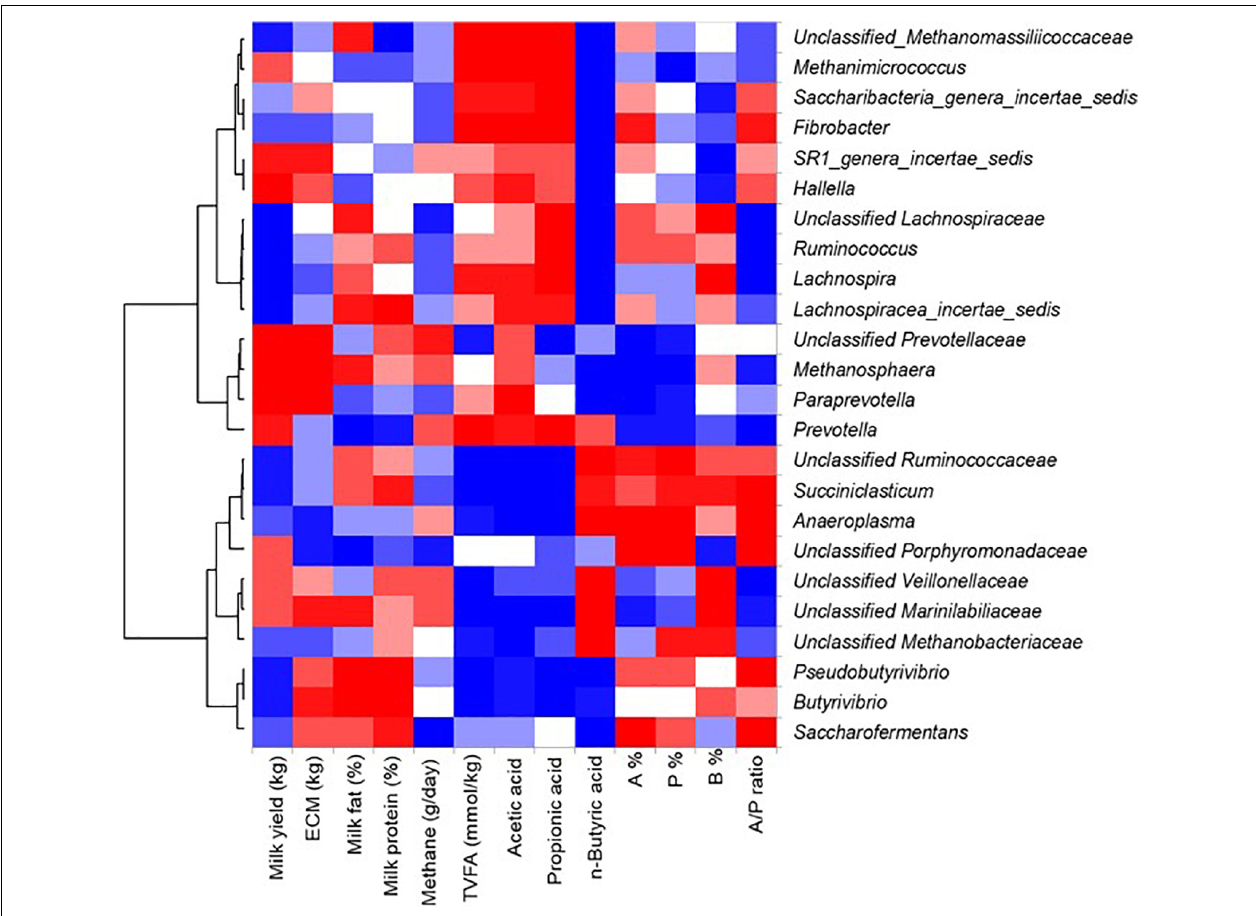
FIGURE 7 | Correlation between SCFAs, milk traits and genus abundance. Pearson correlation analysis between dominant bacterial genera (with relative abundance greater than 0.1%) and concentrations (mmol/kg wet sample) and proportions (%) of SCFAs, milk components (milk yield, energy-corrected milk yield (ECM), milk fat percentage, and milk fat percentage), and methane production (g/day) across the two samplings was performed and the results are shown in Heat map. Only those bacterial taxa showing significant correlations ( P < 0.05), positive (red) and negative (blue), with either of the listed items on the left side are